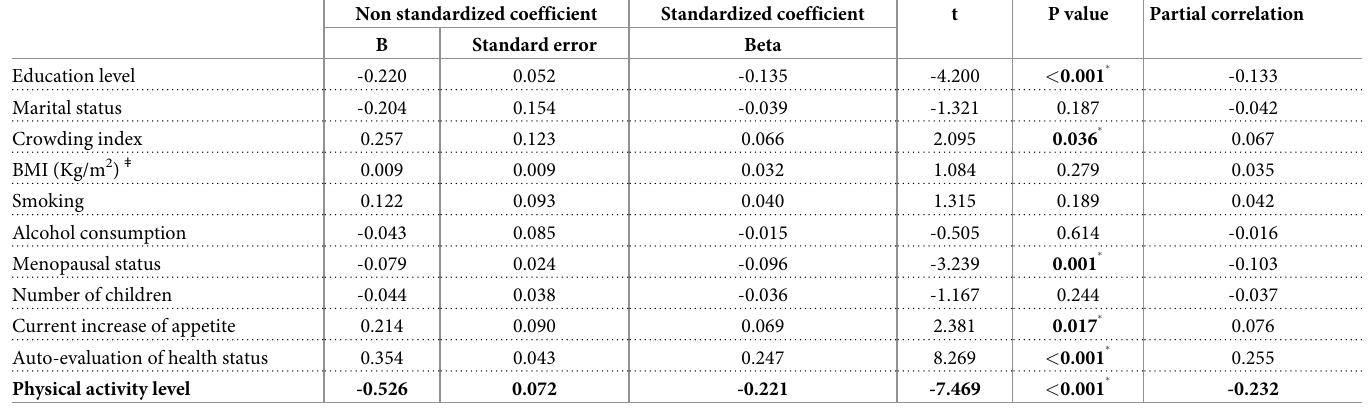
Table 7. Multiple regression of factors associated with the psychosocial subdomain.